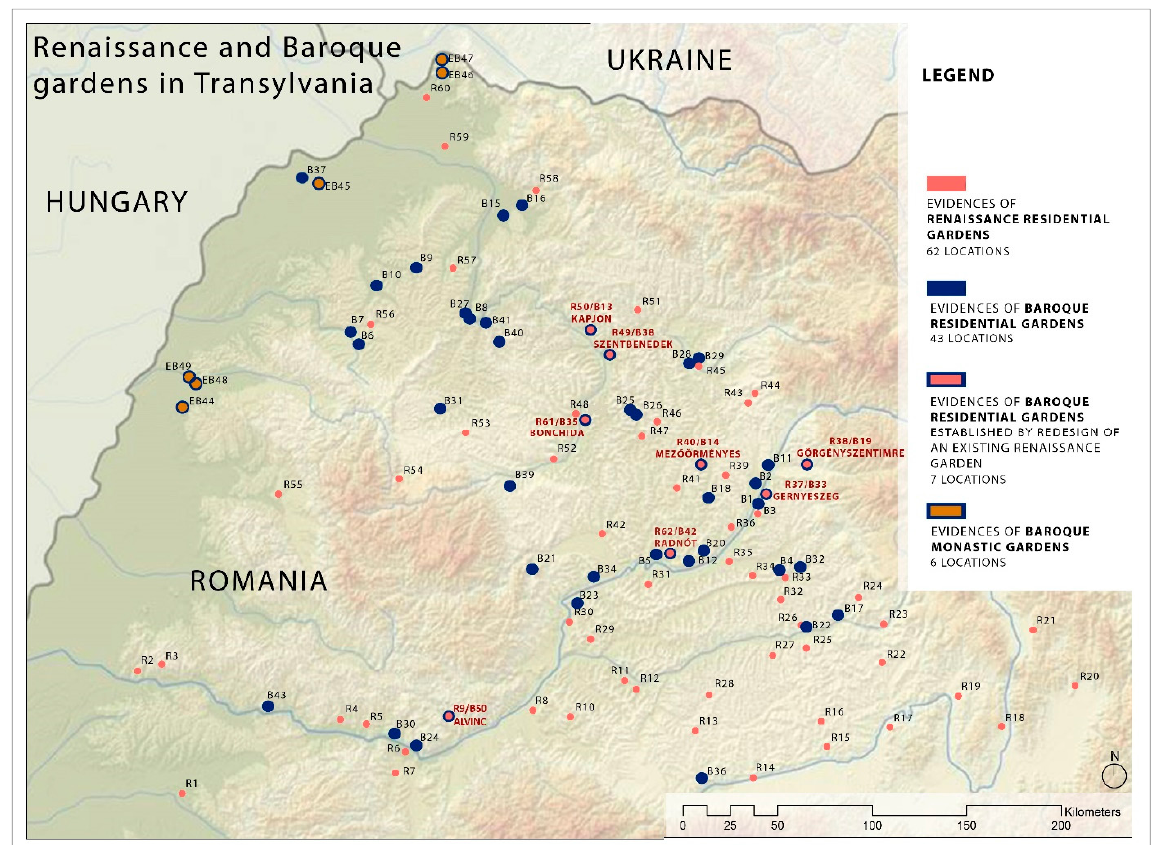
Figure 2. Spatial distribution of Transylvanian Baroque gardens and their relation to the pre-Baroque late-Renaissance Transylvanian garden art; the locations of the Baroque gardens marked on the map can be identified by the numbering assigned to them (B1–B50) using Table 2. Source: prepared by Albert Fekete. Table 1. Comparative analysis of the periods of major garden styles between Western Europe and Transylvania. In the last column the delayed style periods are marked with dark background.